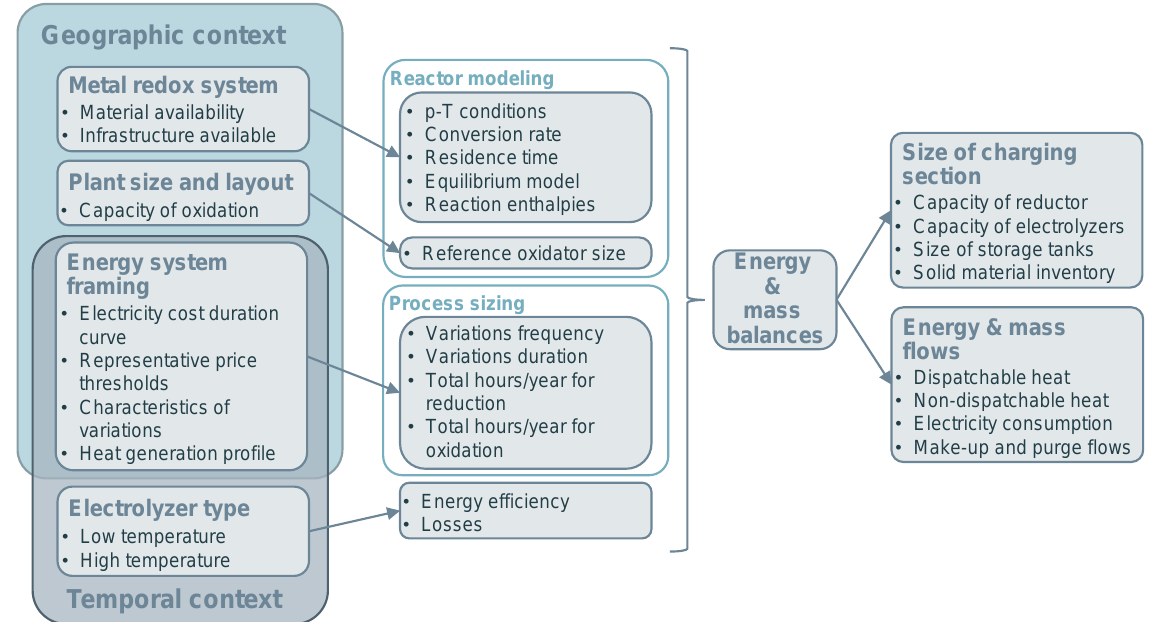
Figure 5. General methodology followed to assess the suggested scheme in given geographic and temporal contexts.